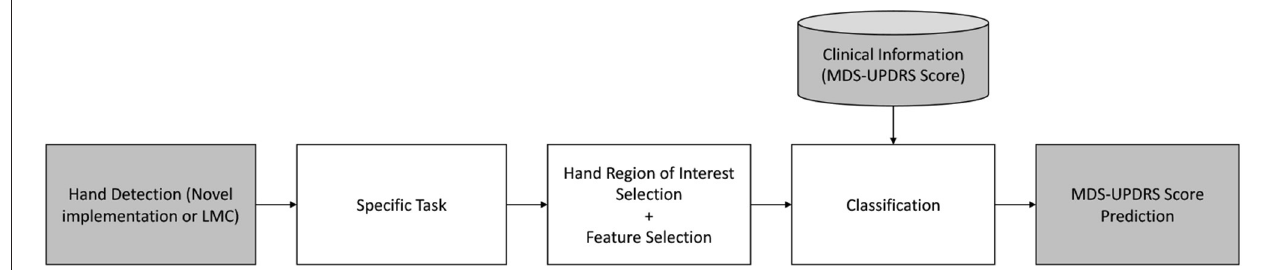
FIGURE 2 | Study design flow diagram.